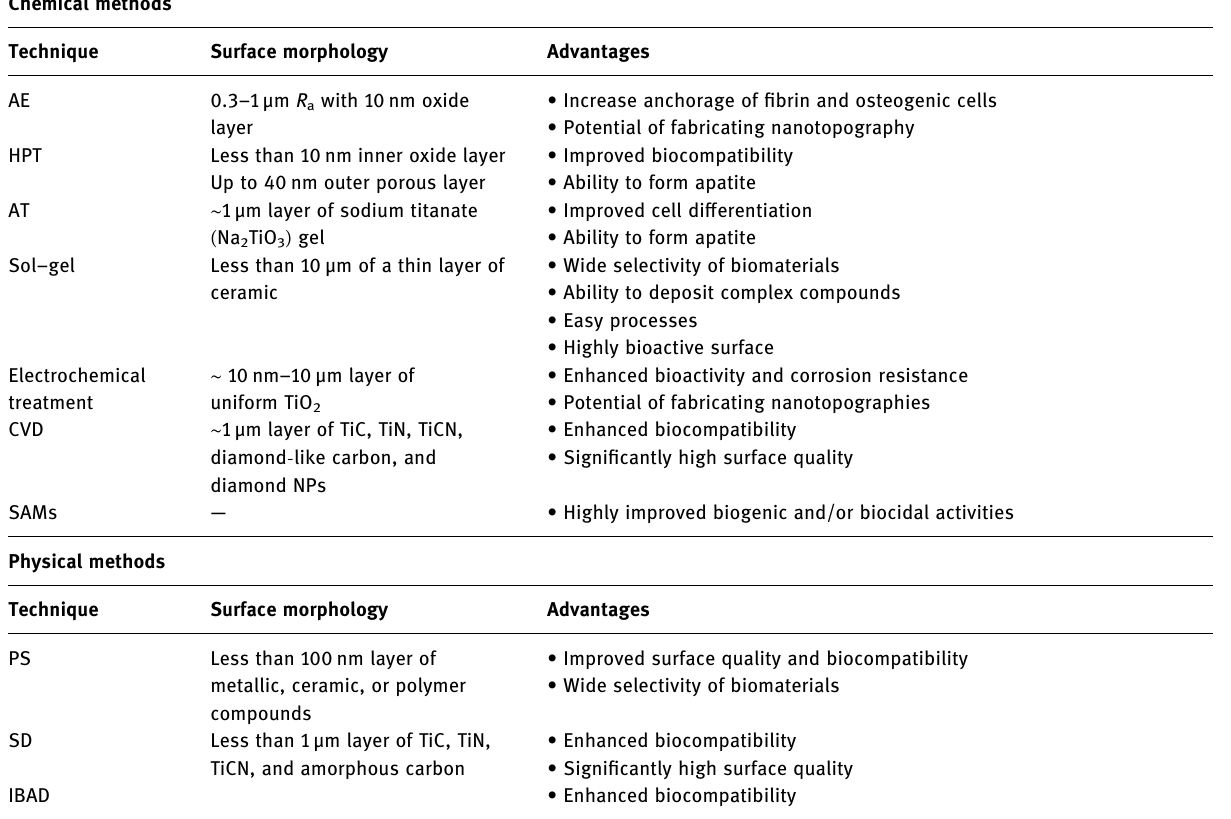
Table 1: A summary of nanofabrication techniques and their advantages for dental implants [ 101 ]